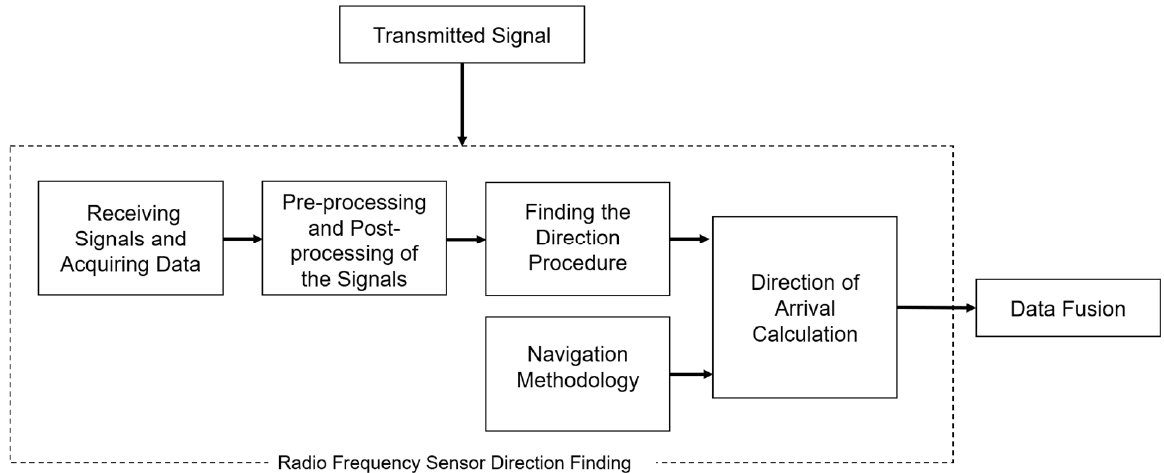
Figure 7. RF sensor direction finding reported in [47] .